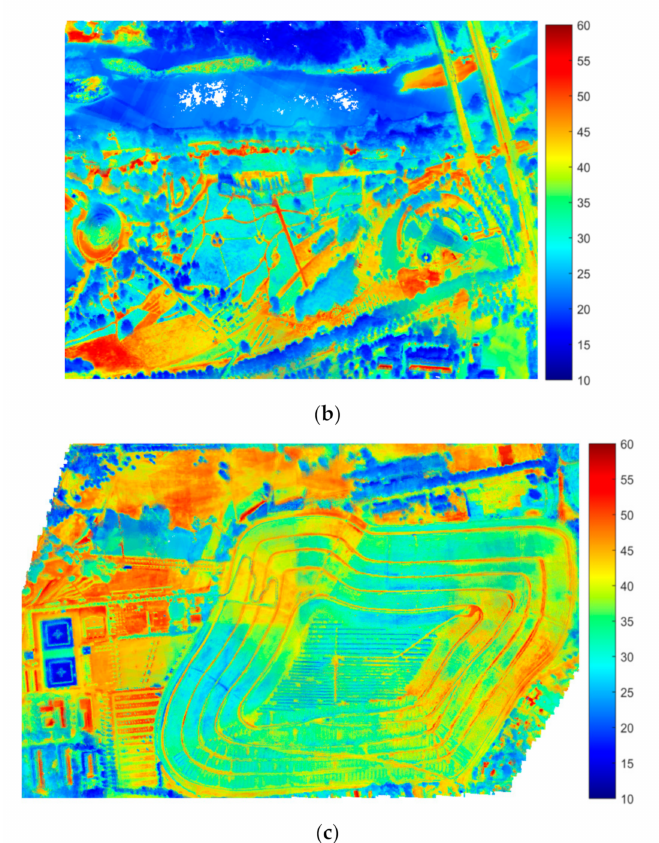
Figure 8. Thermal texture mapping results ( ◦ C) using strategy 2 for ( a ) building area, ( b ) river ecosystem, and ( c ) soil